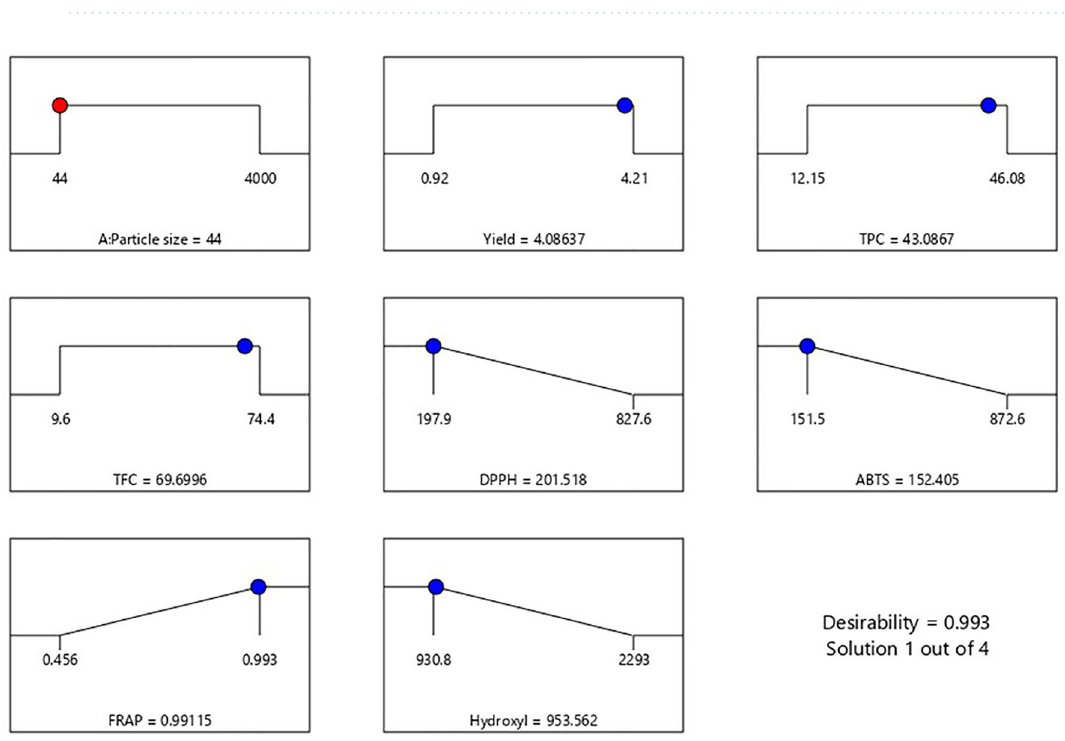
Figure 5. Desirability analysis. Plots ramp showing the optimal particle size that maximize TPC, TFC, and antioxidant